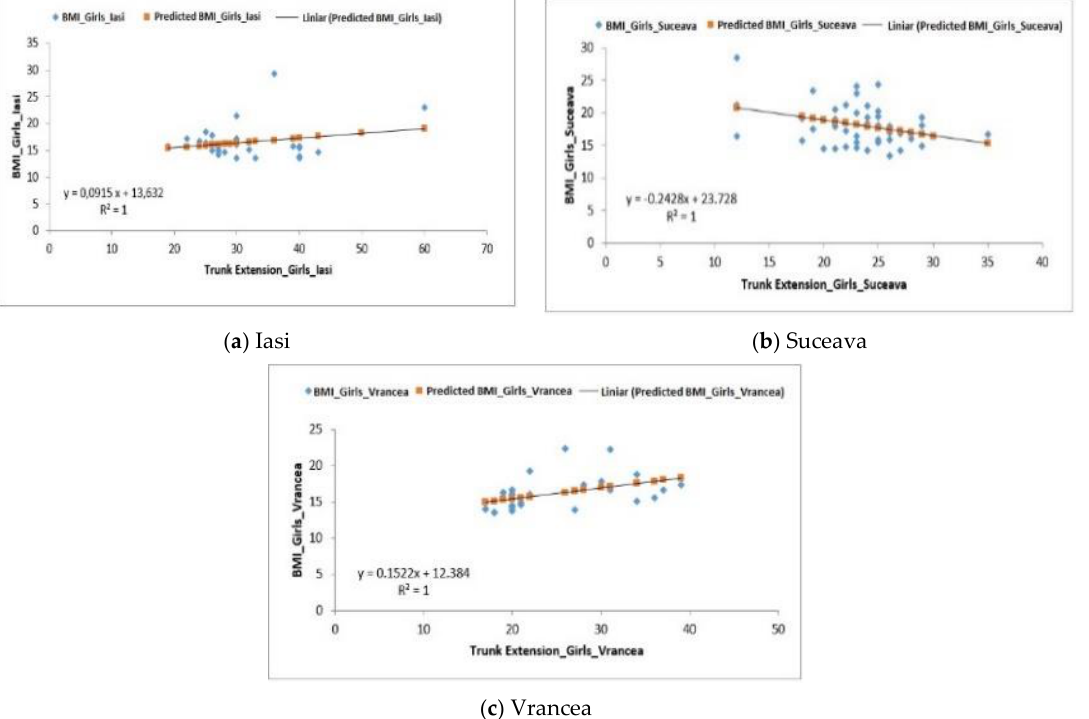
Figure 8. Relationship between the BMI and the upper body extension test for the female subjects in the three regions.